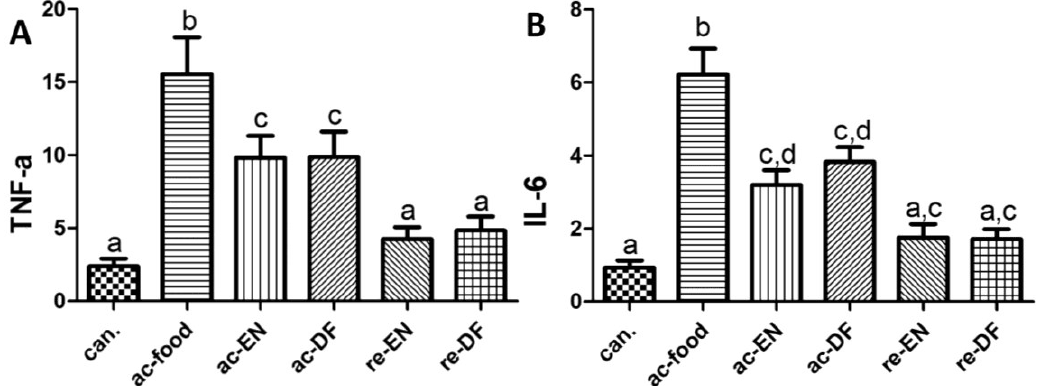
Figure 3. The mRNA of tumor necrosis factor- α (TNF- α ) ( A ) (can. 2.40 ± 1.15,